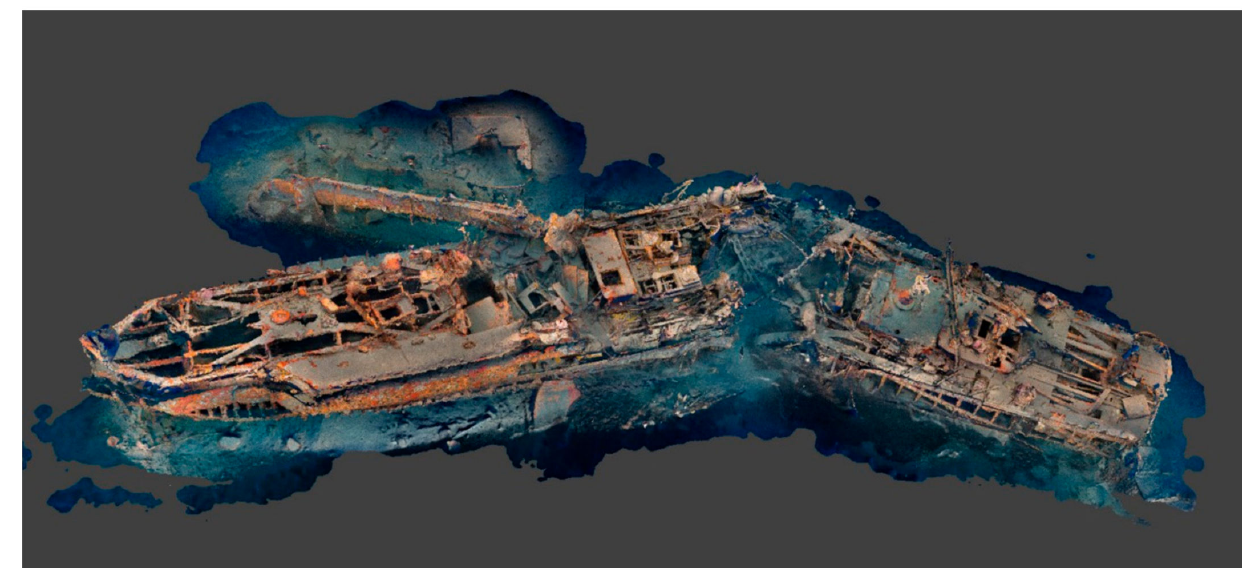
Figure 8. Textured model of the Schnellboot S-31.